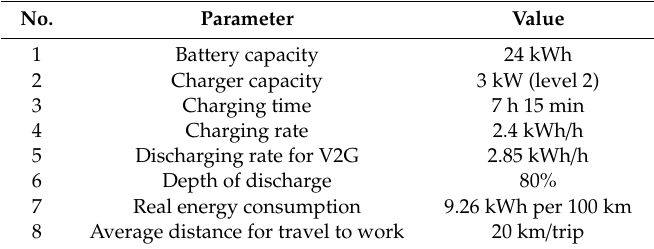
Table 1. Technical parameter for electric vehicles (EVs) and Charger [43,44].